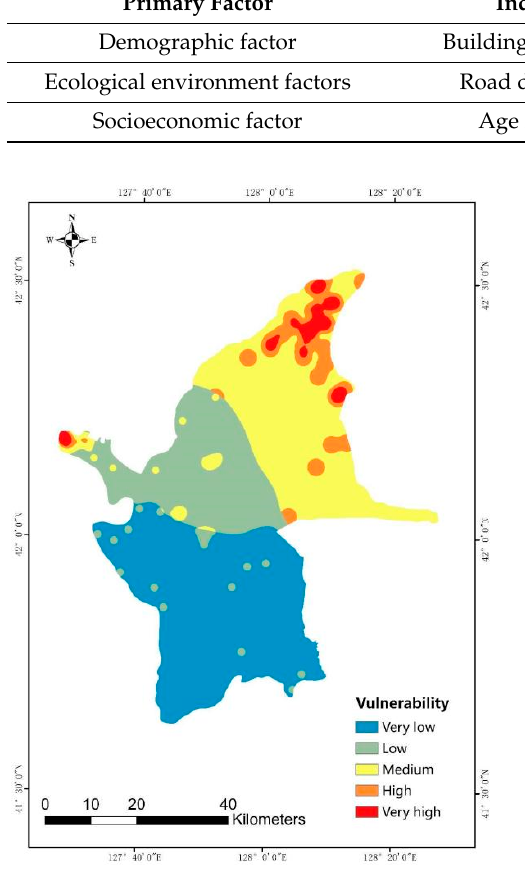
Figure 9. Earthquake landslide disaster vulnerability maps.